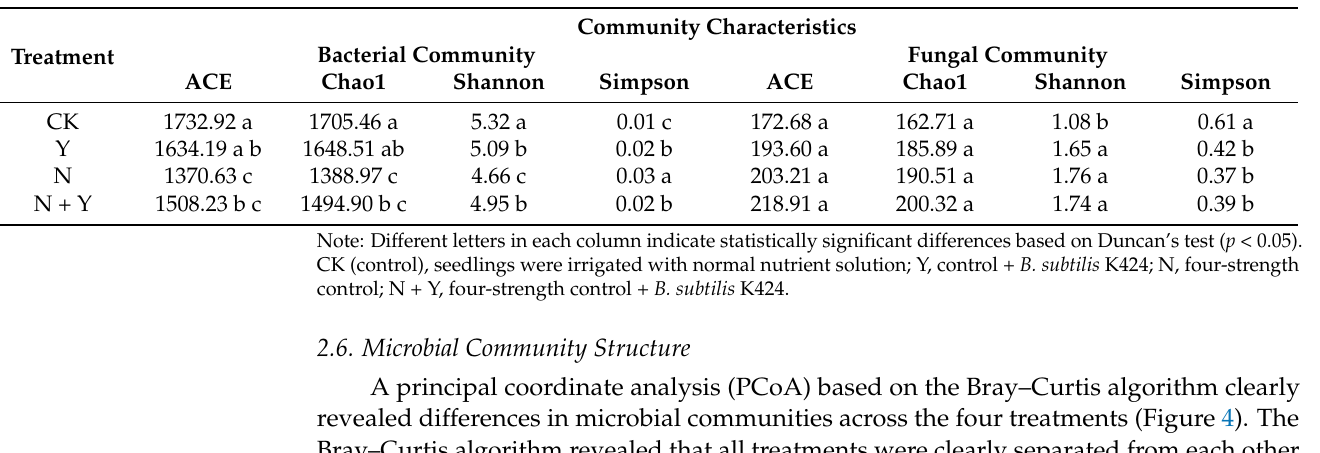
Table 6. The diversity and richness estimates for the different rhizosphere samples at 97% similarity.